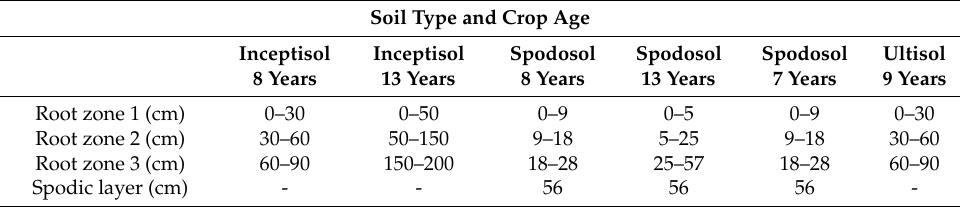
Table 2. The oil palm root zone for varying soil type and crop age.